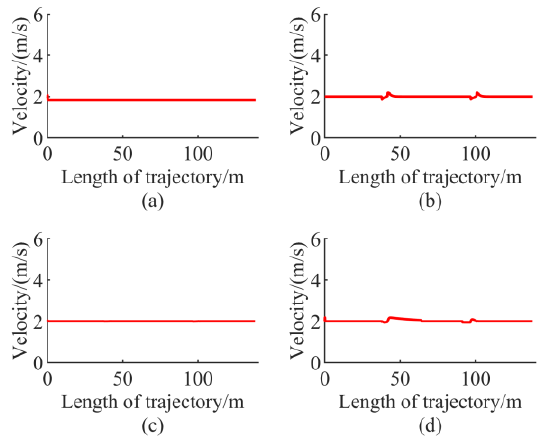
Figure 2. The velocity when velocity is 2 m / s. ( a ) LMPC. ( b ) LEMPC. ( c ) NMPC. ( d ) NEMPC.